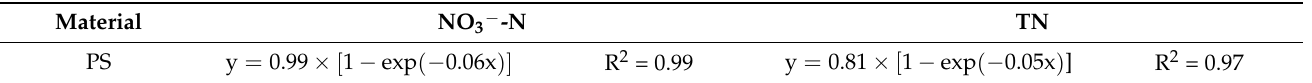
Figure 10. Effects of different carbon sources on denitrification performance in integrated treatment system. ( a ) total nitrogen concentration; ( b ) nitrate concentration; ( c ) ammonium nitrogen concentration. Table 5. Nitrogen removal rate equation of